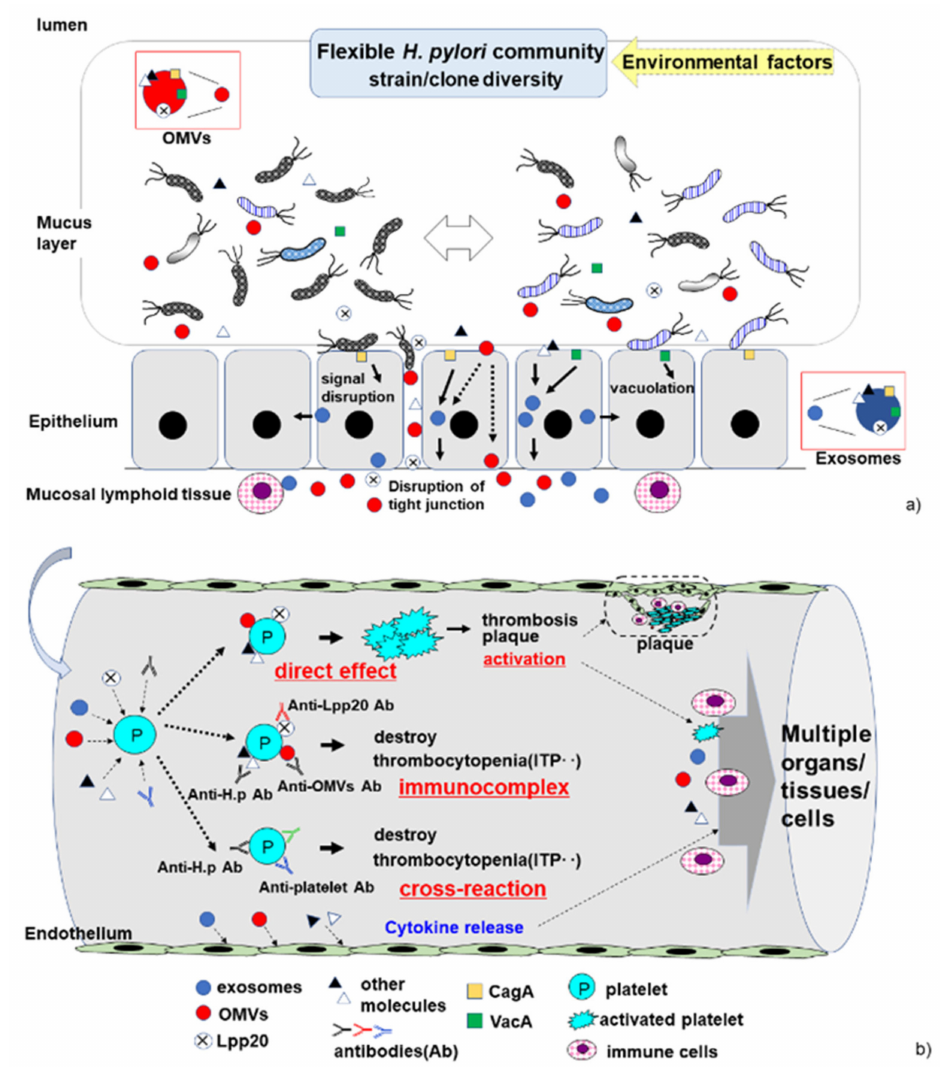
Figure 1. The continuously changing H. pylori community in the stomach, and proposed pathophysi- ological pathways by which H. pylori induces cITP. ( a ) In the stomach, the strain/clone composition of the H. pylori community is highly variable. The bacteria release molecules such as outer membrane vesicles (OMVs) containing pathogenic antigens (i.e., CagA and VacA). Bacterium–epithelial cell interactions can induce host cell damage, disrupt host signal transduction, and lead to the production of exosomes. The bacterial molecules and host cytokines trigger an immune response in mucosal lymphoid tissue. ( b ) In the vessel, the proposed pathophysiological pathways by which H. pylori induces cITP, including cross-reaction, immunocomplex formation, and direct interaction of H. pylori molecules with platelets in the host blood vessels. Exosomes, OMVs, and molecules released by H. pylori affect platelets and the endothelium in the presence or absence of anti- H. pylori antibodies. These bacterial factors (exosomes, OMVs, Lpp20, and other molecules) may bind directly to platelets, leading to platelet activation. The production of a variety of anti- H. pylori antibodies contributes to platelet destruction via cross-reaction and immunocomplex formation in H. pylori -associated